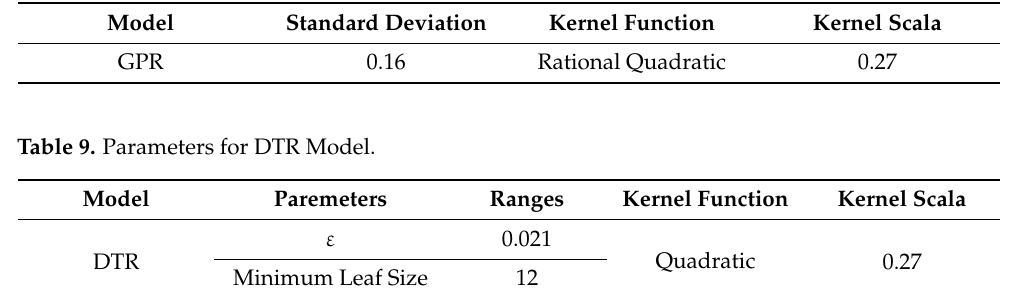
Table 8. Parameters for GPR Model.